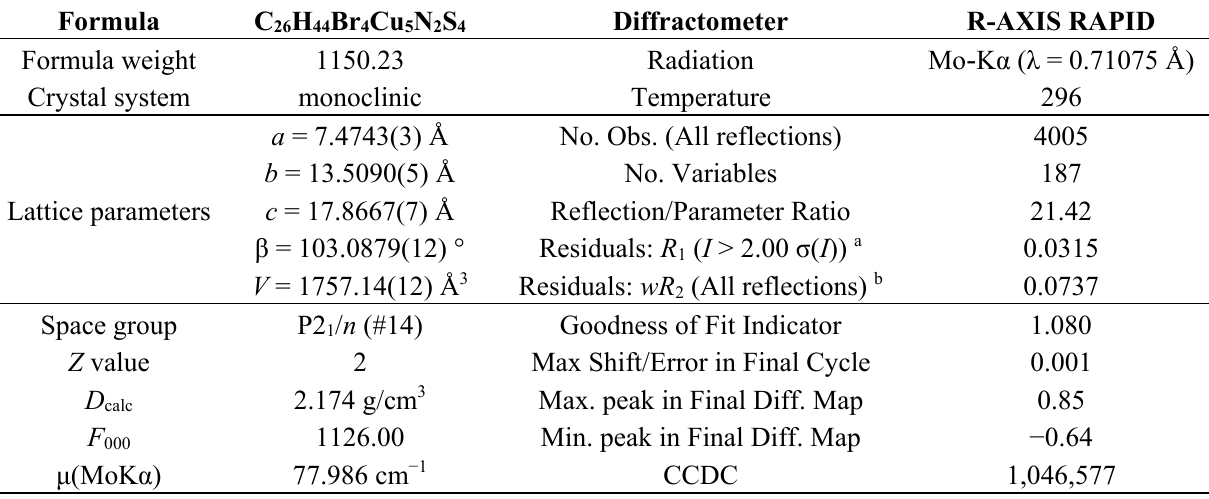
Table 2. Crystal Data and Structure Refinement Parameters for 1